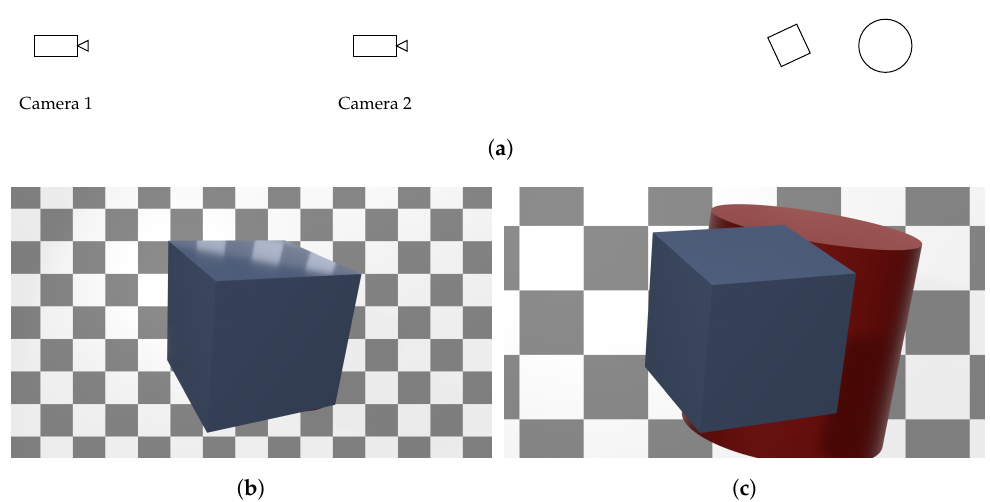
Figure 2. Modifying the focal distance and distance between camera and objects can have an important impact on the picture by revealing hidden objects and changing their shape. ( a ) Setup, ( b ) camera 2, with a short focal length and ( c ) camera 1, with a long focal